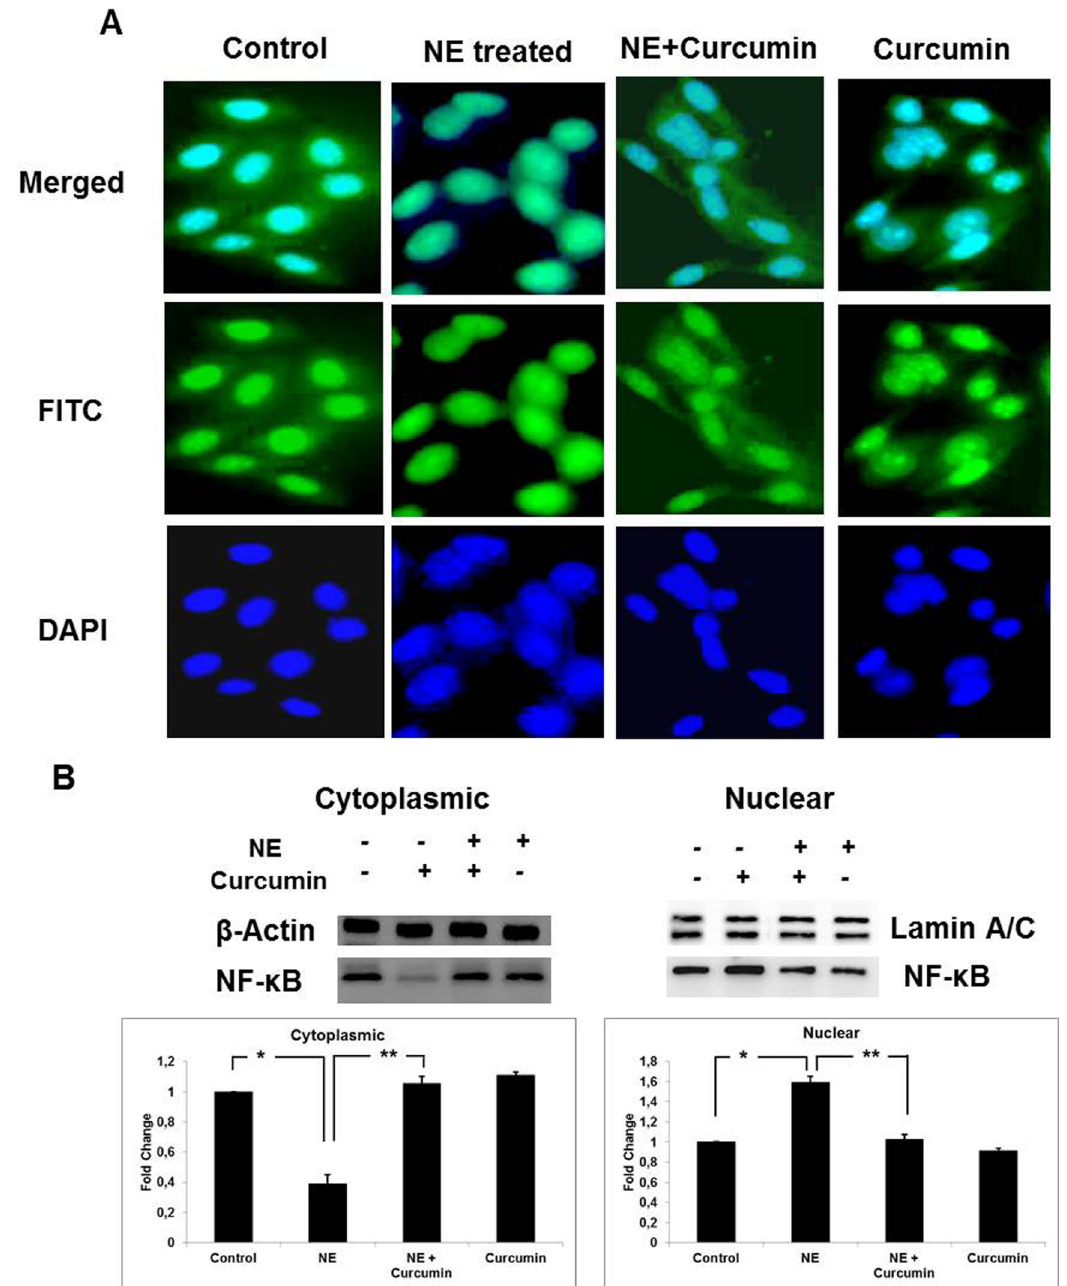
Figure 5. Nuclear localization of NF-κB. ( A ) Immunofluorescence for NF-κB : Nuclear localization of NF-κB was compared between H9c2 Control cells, NE-treated cells NE+Curcumin-treated and Curcumin-treated alone cells. Blue color represents DAPI staining of nucleus. NF- κB was stained green. ( B ) Western Blotting : Nuclear and cytosolic proteins from different Samples in different lanes for both nuclear and cytosolic extract panels starting from the left represented as Lane-1: Control; Lane-2: NE- treated; Lane-3: NE+Curcumin-treated; Lane-4: Curcumin-treated alone. Protein expression observed through Western blotting was quantitated by NIH ImageJ software. Results obtained were normalized against beta actin for cytoplasmic extracts and Lamin A/C for nuclear extracts and plotted as a histogram (*P<0.01, **P<0.05). NE-treated group showed a significant difference compared to control and NE+Curcumin-treated group.